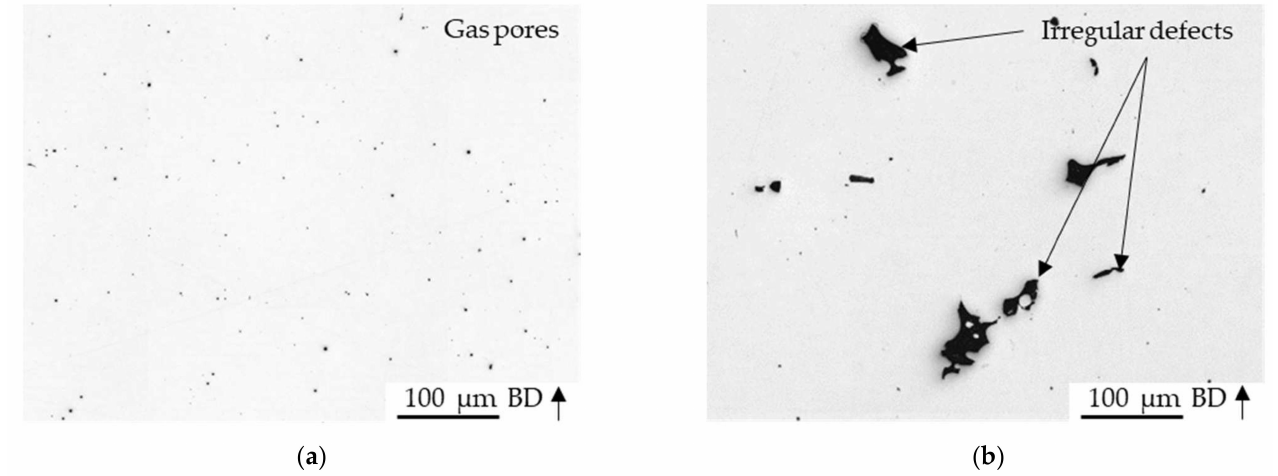
Figure 6. Representative microsections with indicated porosity types in the AB condition under an ( a ) argon atmosphere or ( b ) nitrogen atmosphere. BD: building direction.